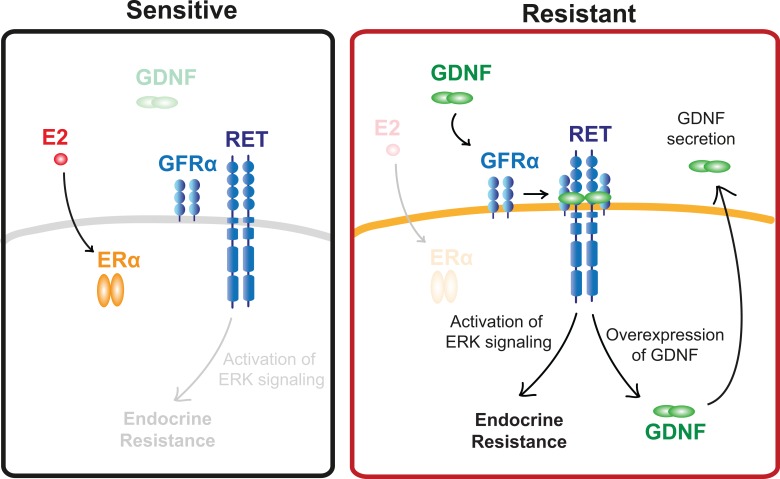
Schematic diagram of RET activation in endocrine sensitive and resistant tumors.Both endocrine sensitive and resistant breast cancer cells express all components of the RET signaling pathway, but endocrine sensitive breast cancer cells lack GDNF to initiate the resistance pathway. By contrast, endocrine resistant cells secret GNDF, which acts in an autocrine or paracrine fashion to promote endocrine resistance in nearby cells.